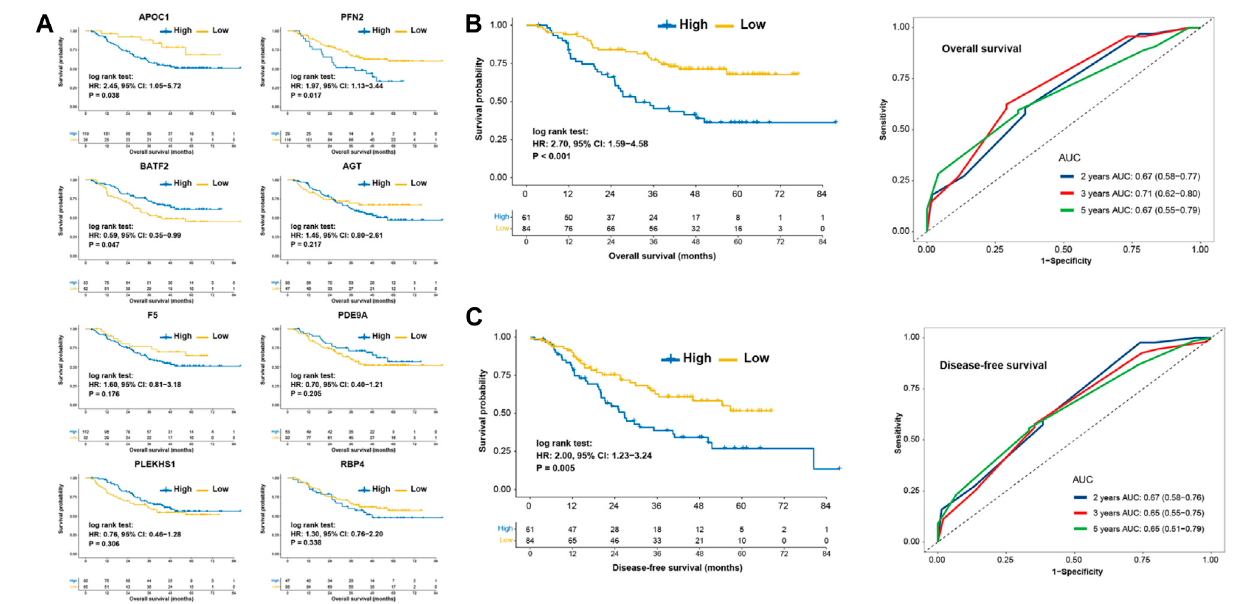
FIGURE5| PrognosticvaluesofpyroptosisriskscoreintheSYSUCCcohort. (A) Kaplan-Meiercurvesofoverallsurvivalofpatientswithlow-orhigh-expressionof 8 eight genes. Kaplan-Meier curve and Time-dependent ROC for 2, 3, 5 years based on pyroptosis risk score in the SYSUCC cohort regarding overall survival. (B) and disease-free survival. (C) SYSUCC, Sun Yat-Sen University Cancer center.